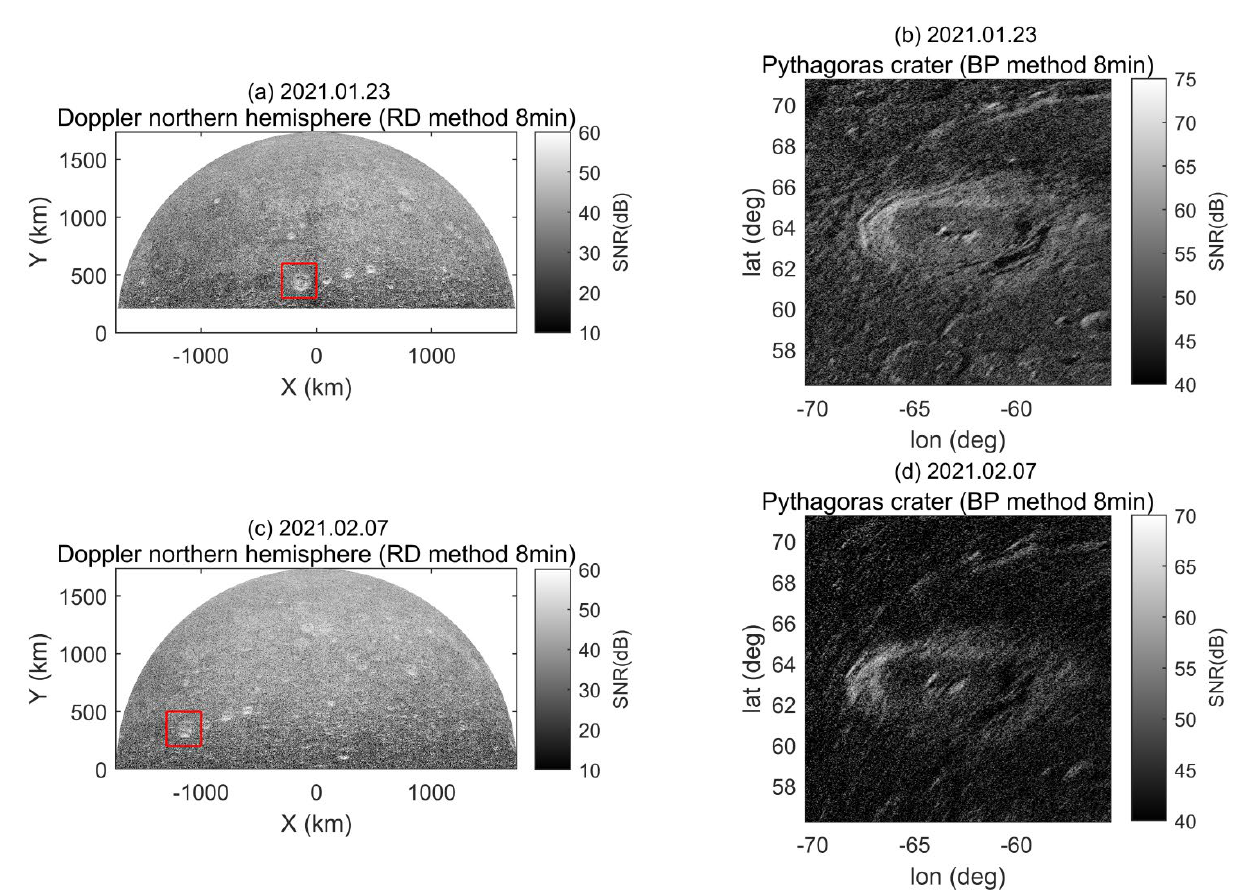
Figure 6. Imaging results used to explain why not to average multiple images obtained from the experiments on different dates. ( a , b ) are the results of the experiment on 23 January 2021. ( c , d ) are the results of the experiment on 7 February 2021. ( a , c ) are the images of the Doppler Northern Hemisphere of the front side of the moon. These images are obtained by the range-Doppler algorithm with a coherent integration time of 8 min. ( b , d ) are the images of the Pythagoras crater region obtained by the back projection algorithm with a coherent integration time of 8 min. The red rectangles represent the position of the Pythagoras crater region on the Doppler northern hemisphere of the front side of the moon.